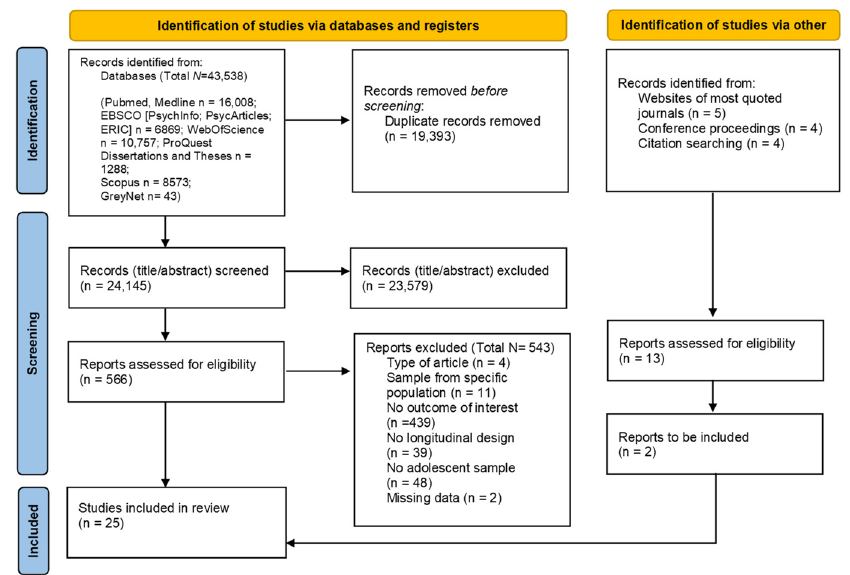
Figure 1. PRISMA diagram search flow.